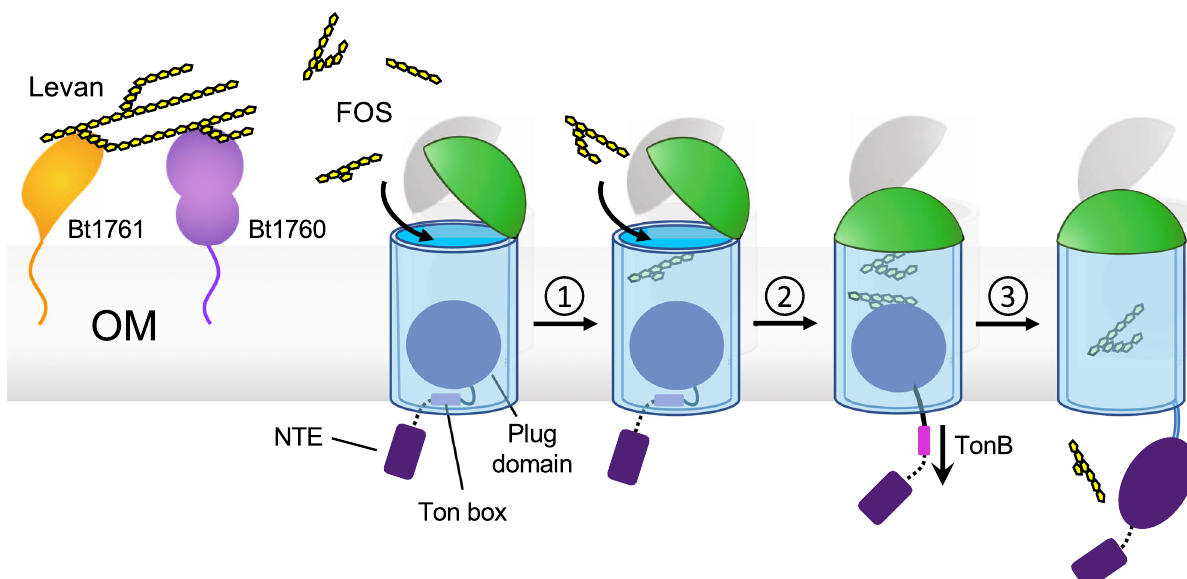
Fig. 8 Model demonstrating the proposed mechanism of substrate capture and translocation by Bt1762-63. Levan polysaccharide is initially bound and hydrolysed at the cell surface by the SGBP Bt1761 and GH32 endo-levanase Bt1760, respectively, although the precise role of the SGBP is unclear. A lid- open state of the transporter permits binding of transport-competent FOS. ① Contributions from both SusC and SusD to FOS binding elicits closure of the lid. ② Multiple cycles of lid opening and closing occur until the SusC “ bin ” is fully loaded with substrate, forming the transport-ready state of the complex. Substrate loading is communicated across the outer membrane by direct contact with the Bt1763 plug domain, inducing perturbation of the Ton box region on the periplasmic side of the plug, rendering it accessible to TonB. ③ TonB-mediated disruption/extraction of the plug permits substrate translocation. Details of the “ reset ” mechanism are unclear, but reinsertion of the plug is likely a prerequisite to restoring the open state of the